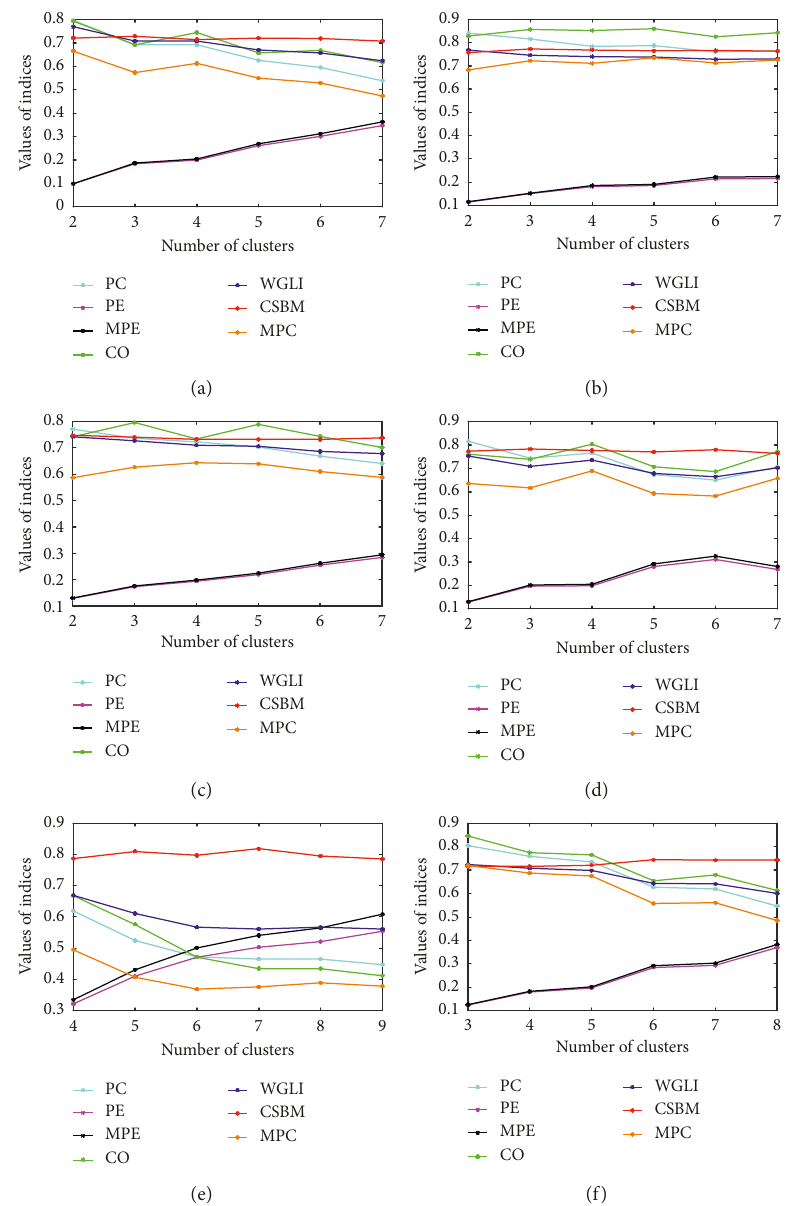
Figure 2: The variation trend of each index with the number of cluster ( C ) after adding noise data. (a) Iris. (b) Wine. (c) Wpbc. (d) Hayesroth. (e) Zoo. (f)